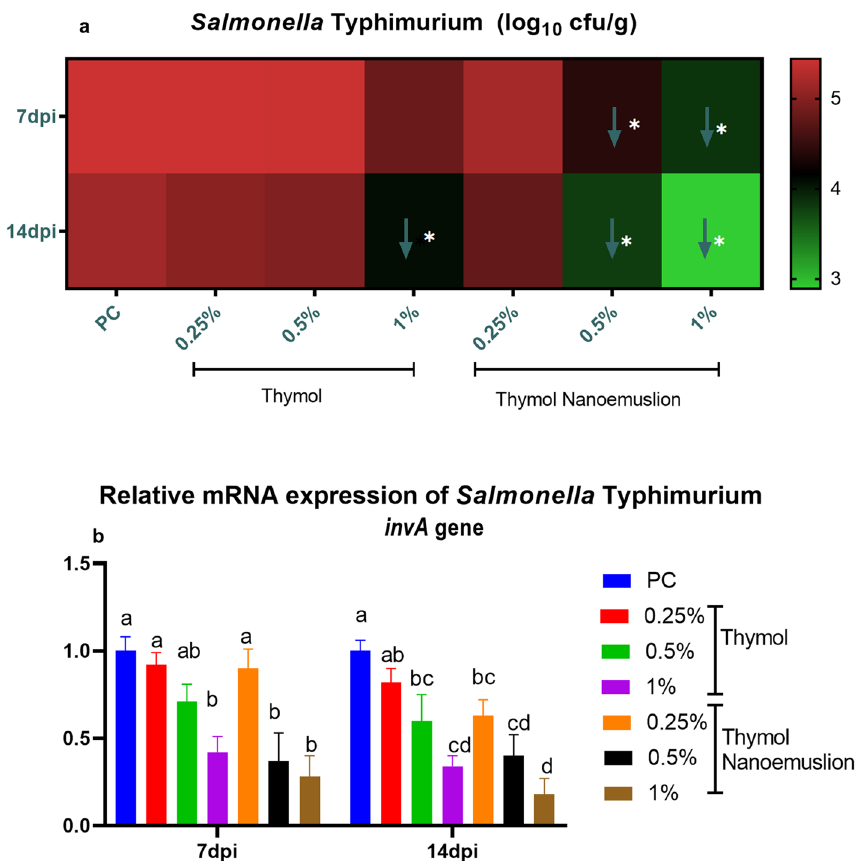
Figure 6. Quantification of cecal S . Typhimurium populations ( a ) and its invA mRNA ( b ) in response to thymol and thymol nanoemulsion supplementation at 7 and 14 dpi as were measured by real-time PCR assay. Data are expressed as means ± SE (error bars). Arrows corresponded to significant decrease ( ↓ ) relative to the PC group ( p < 0.05). NC (negative control): birds fed basal diet; PC (positive control): birds fed basal diet and challenged with S . Typhimurium at d 23 of age; thymol 0.25, 0.5 and 1%: birds fed basal diet supplemented with 0.25, 0.5 and 1% thymol; thymol nanoemulsion 0.25, 0.5 and 1%: birds fed basal diet supplemented with 0.25, 0.5 and 1% thymol nanoemulsion. All groups except NC group were challenged with S . Typhimurium at d 23 of age. a–d Means within the same column carrying different superscripts are significantly different at p <